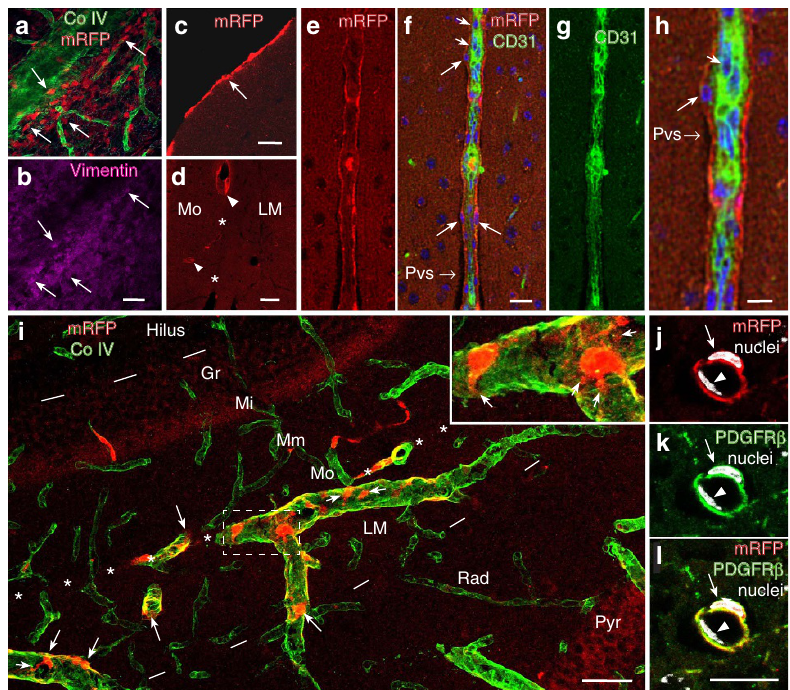
membrane collagen IV (CoIV, green), decorated by leptomeningeal cells that contain mRFP-HCAR1 (red) and co-localize fibroblast marker vimentin (magenta, b ); confocal images from top frozen section tangential to the brain surface. Scale bar, 70 m m. ( c ) Pial cells (arrow) in confocal image of parasagittal frozen section perpendicular to the cerebral cortex of mRFP-HCAR1 reporter mouse. Scale bar, 20 m m. ( d ) In the extension of pia in fissura hippocampi (*), which separates hippocampus stratum lacunosum-moleculare (LM) from the molecular layer of area dentata (Mo), mRFP-HCAR1 is in select blood vessels (arrowheads), including ones (small arrowhead) penetrating into the Mo. Scale bar, 50 m m. ( e – h ) Blood vessel penetrating into